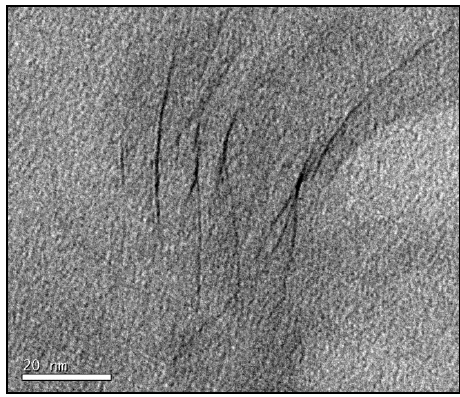
Figure 8. TEM micrograph for a sample with 2 wt% MMT, prepared by pre-conditioning at RT for 225